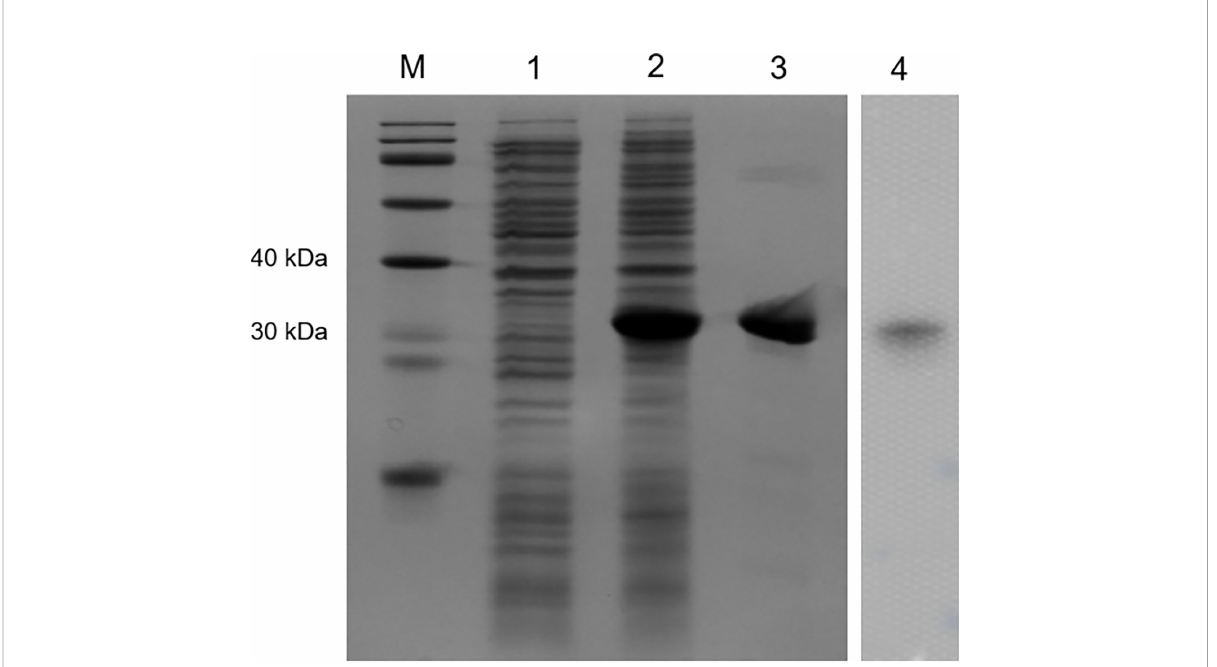
FIGURE 3 SDS-PAGE analysis and western blotting detection of recombinant protein rOppLTL. Lane M: marker; lane 1: extracts from expressing strains before isopropyl b -D-thiogalactopyranoside (IPTG) induction; lane 2: extracts from IPTG-induced expressing strains; lane 3: puri fi ed rOppLTL; lane 4: western blot of puri fi ed